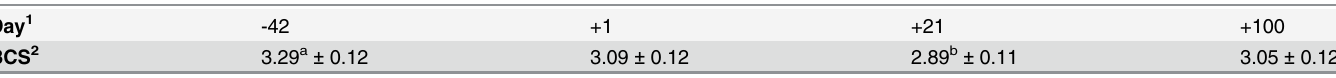
Table 1. Body condition score (BCS) of dairy cows corresponding to biopsy